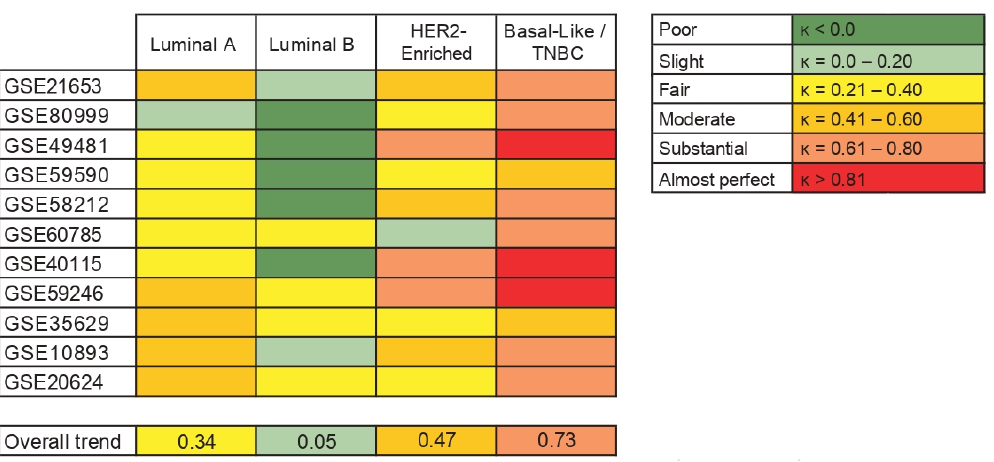
Figure 5. AR mRNA level is significantly increased in patients categorized with less aggressive IHC-surrogate subtypes. Results after sensitivity analyses. Forest plots of SMD comparing AR mRNA levels in BC patients classified as TNBC subtype vs. Luminal A ( A ), Luminal B ( B ), and HER2-enriched subtypes ( C ). The squares represent the SMD for each dataset. The horizontal line crossing the square represents the 95% CI. The red diamonds represent the estimated overall effect.